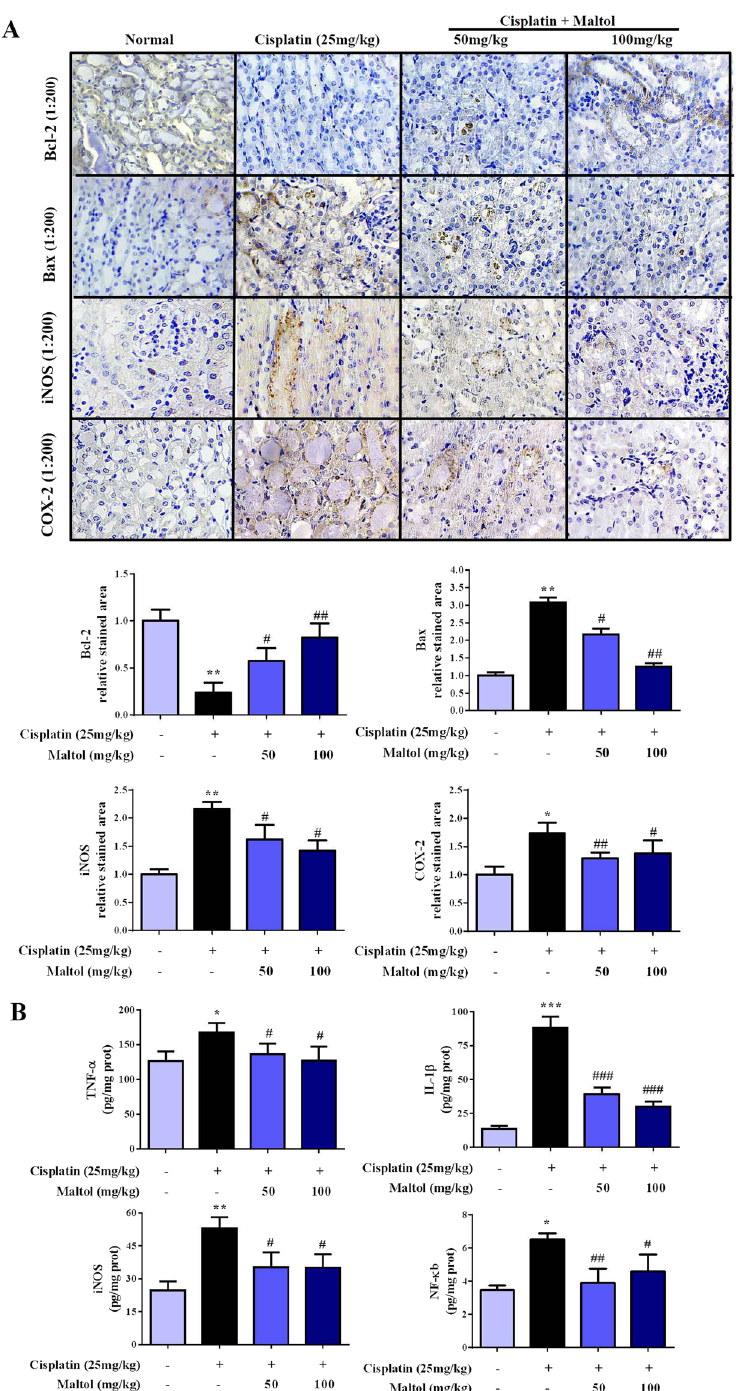
Figure 4. Effects of maltol on the levels of inflammation cytokines in cisplatin-induced renal toxicity. ( A ) Effects of maltol on the positive expressions of Bax, Bcl-2, iNOS and COX-2 in renal tissues were examined by IHC in renal tissues (magnification × 200), And the column chart shows stained area, semiquantitative analysis of Bax, Bcl-2, iNOS and COX-2 expression in kidneys to IHC. ( B ) Inflammation cytokines level of TNF- α , IL- 1 β , iNOS and NF- κ B in serum of mice were measured by ELISA kits. All values were expressed as mean ± S.D. * p < 0.05, ** p < 0.01 vs . normal group; # p < 0.05, ## p < 0.01 vs . cisplatin